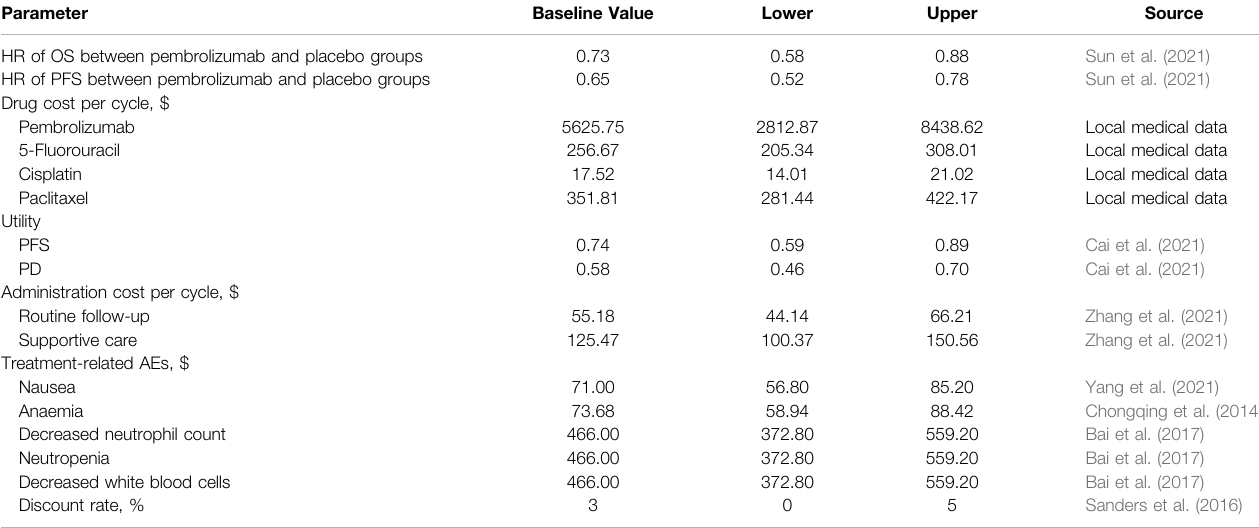
TABLE 1 | Model parameters: baseline values and ranges.